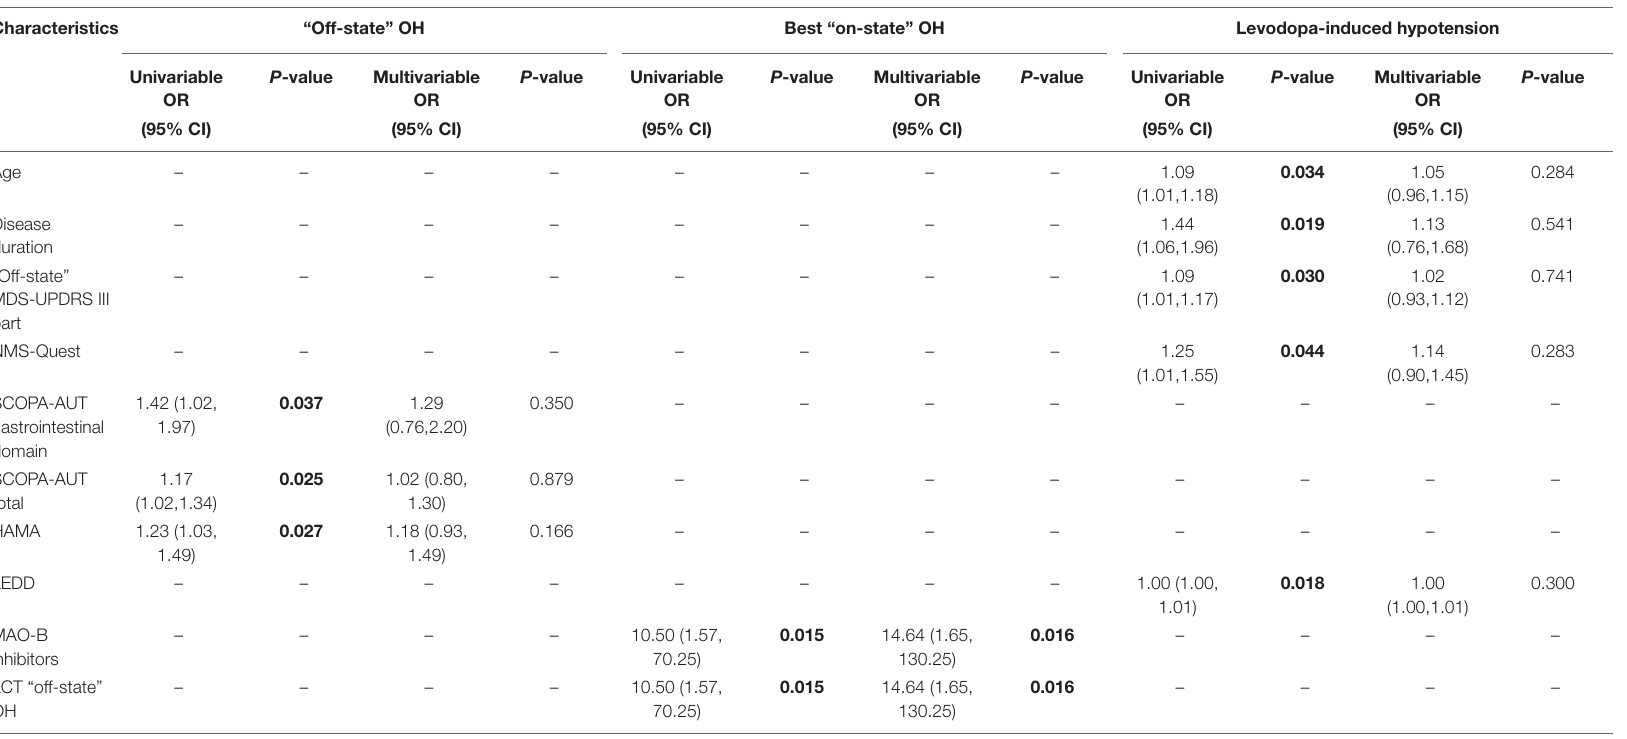
TABLE 3 | Logistic regression analysis of the risk factors related to OH and levodopa-induced hypotension in levodopa challenge test.